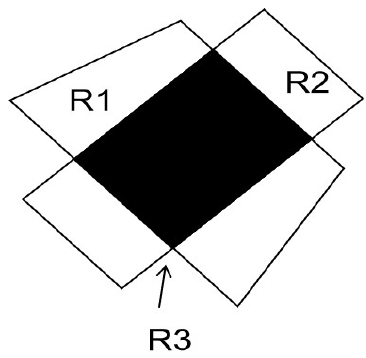
Figure 9. Charging coverage after waveform positioning.